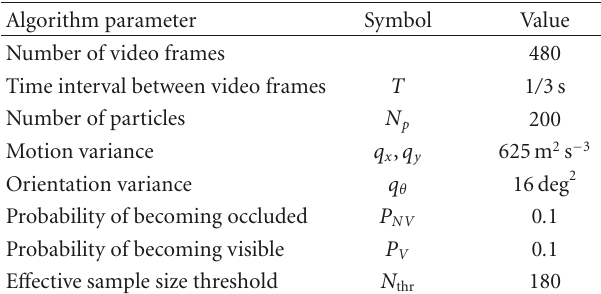
Table 1: Tracking parameters for particle